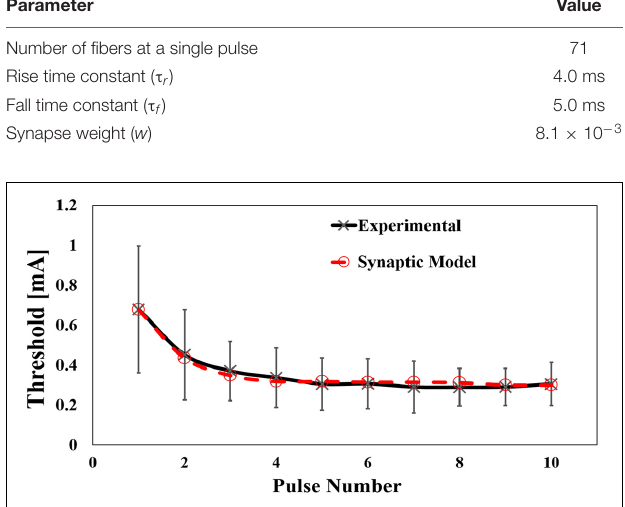
FIGURE 6 | Computed results of the effect of pulse number by pulse-train electrical stimulation (experimental mean value and standard deviation, n = 8).